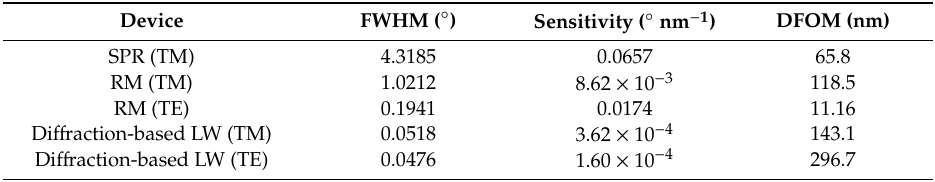
Table 1. Comparison of the theoretical dispersion characteristics of surface plasmon resonance (SPR), resonant mirror (RM) and di ff raction-based leaky waveguides